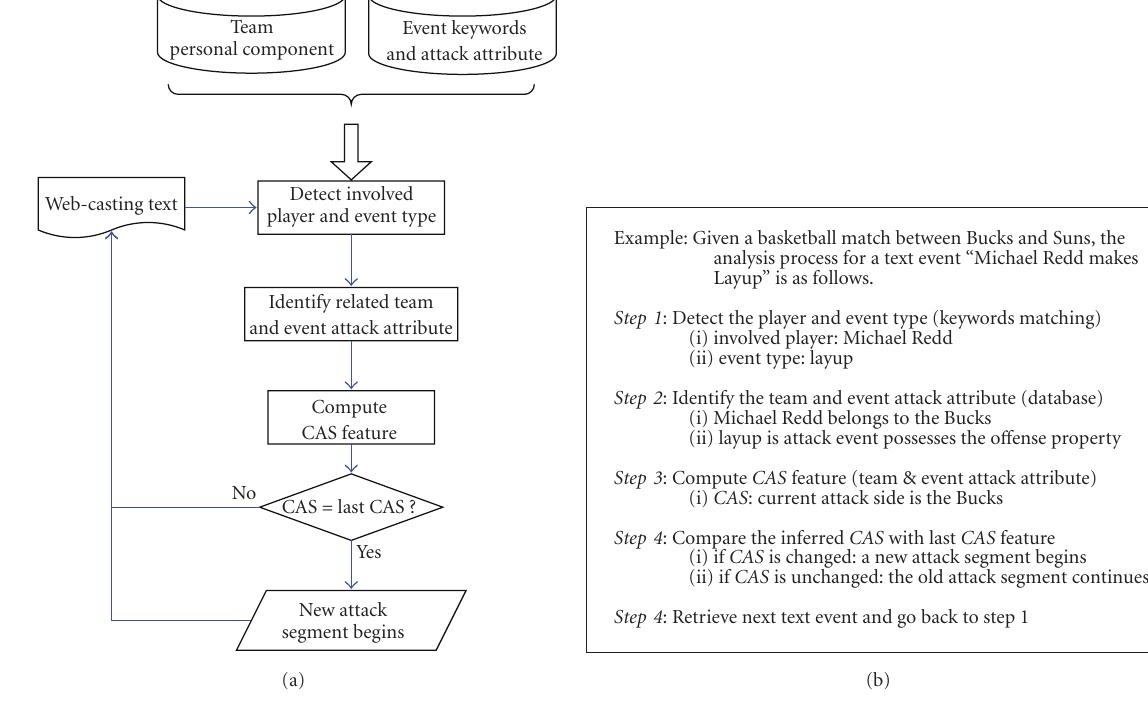
Figure 5: Attack-based text segmentation (a) algorithm flow and (b) an example. Table 2: Event keywords and attack